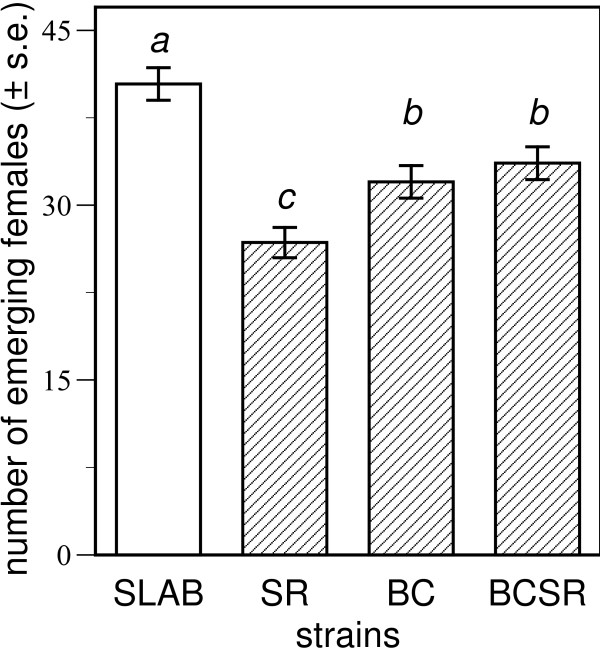
Costs of resistance in an insecticide-free environment. The number of female mosquitoes emerging in an insecticide-free environment. Insecticide susceptible strain SLAB is shown in an open column and the three resistant strains are shown in hatched columns. In two replicate experiments, there were nine or ten pots initially containing 100 larvae for each of the four strains. Different letters above columns indicate significant differences (p < 0.05) in female emergence as found by a Tukey-Kramer test (see text for details).